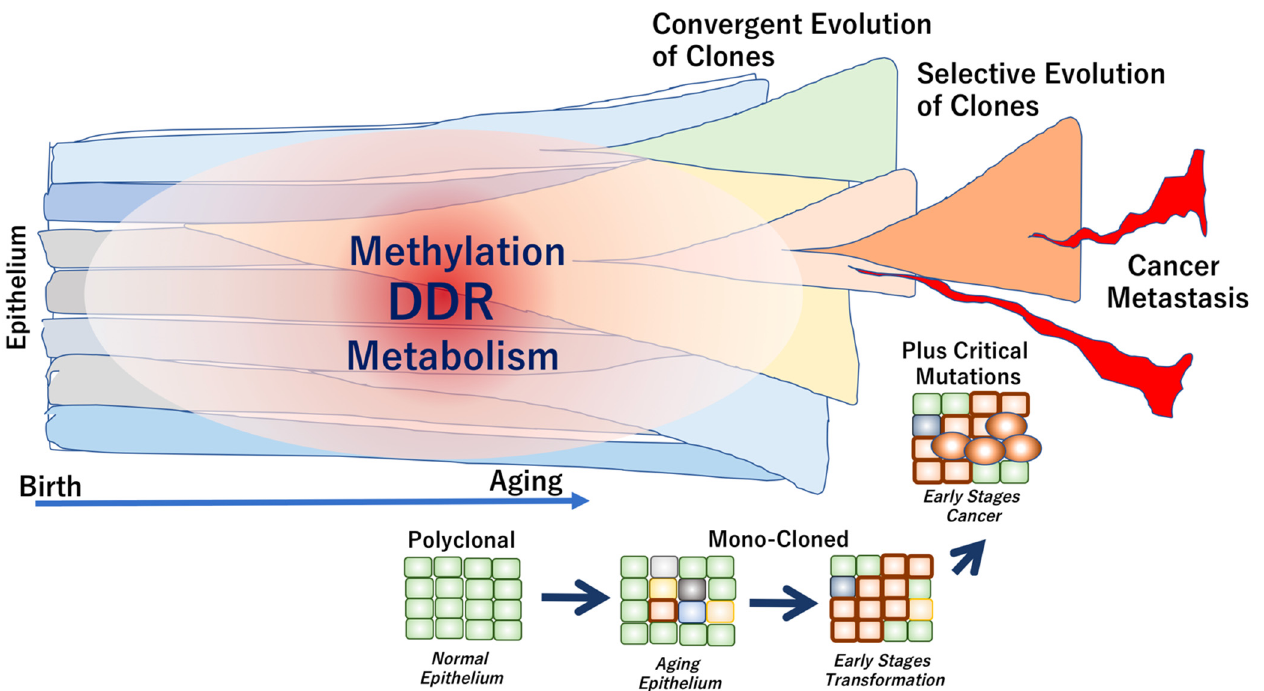
Figure 2. Genome aging associated with epithelial cell transformation and cancer development. In healthy individuals, the normal epithelium is composed of polyclonal components. The clonality is altered toward mono-clonal characteristics during the early stages of transformation, often leading to cancer development. In carcinogenesis, critical driver mutations may occur during exposure to exogenous stimuli or environmental carcinogens. The epithelial clones can be evolved from convergent to selective phenotypes, which are often associated with the development of metastasis and cancer progression [52].